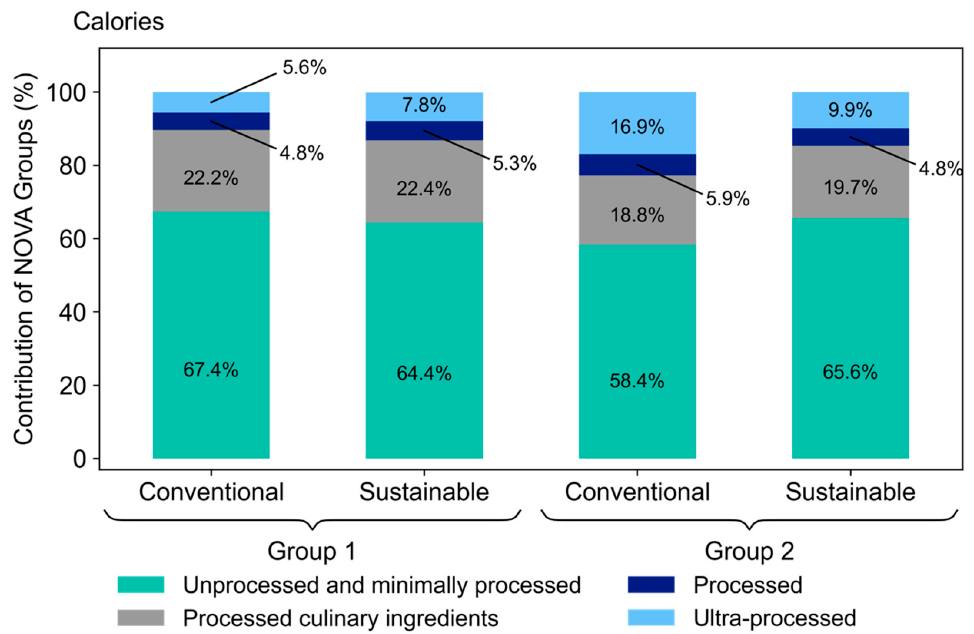
Figure 1. Share (%) of NOVA food groups to total calories in conventional and sustainable menus.